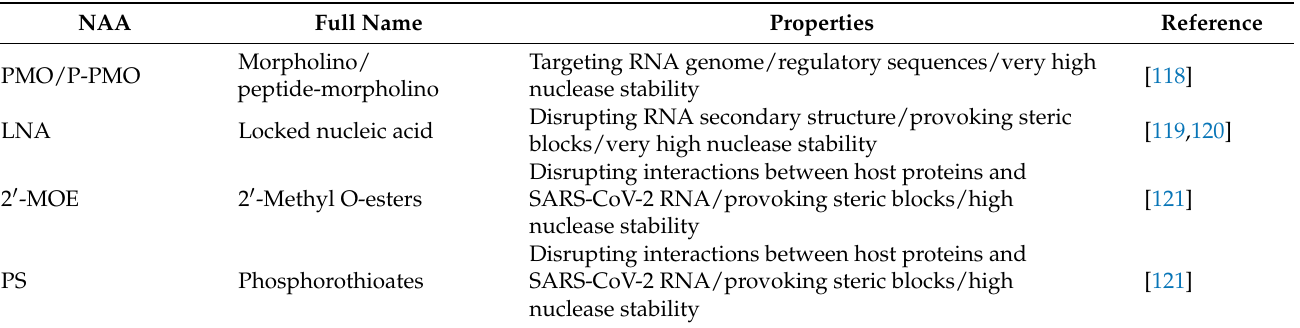
Table 2. Some of the most used nucleic acid analogs (NAA) and their main anti-SARS-CoV-2 applications.